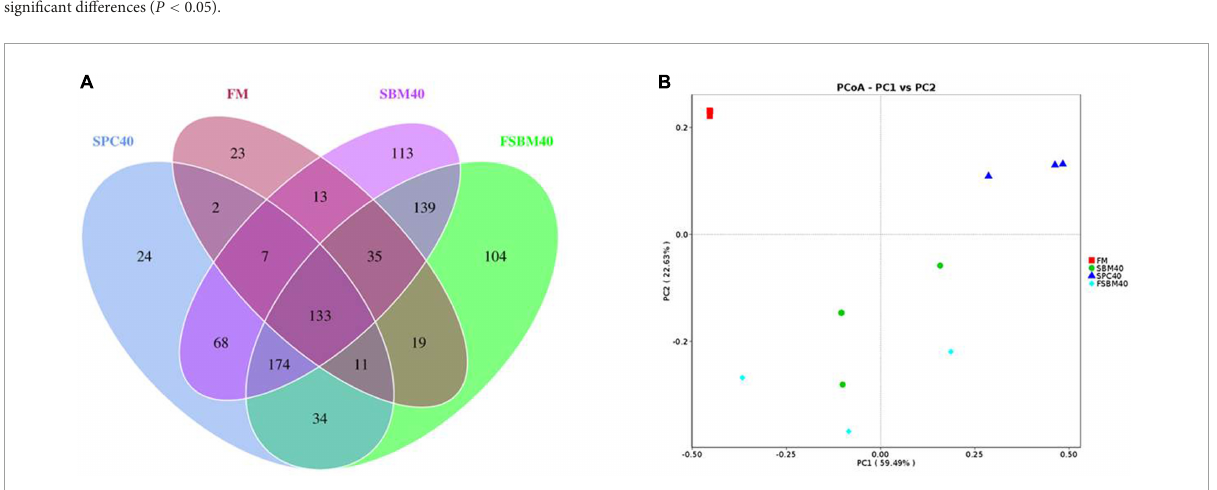
between the SPC40 and FSBM40 groups ( P > 0.05). The abundances of the left species significantly increased in all soy meal substitution groups ( P < 0.05; Figures 3C,D